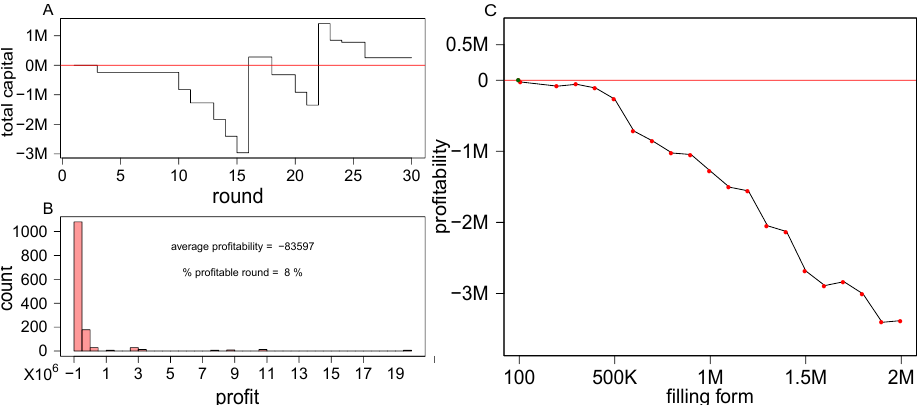
Figure 5. Assessing the selected model’s performance. ( A ) An example of a typical simulation. Vertical jumps of the curve indicate rounds in which the model output was to place a bet in the specific round (x-axis) by filling the 200 K top ranked forms. ( B ) Shows the profit distribution of single rounds from 100 simulations of 30 rounds, in which the model output was to place a 200 K forms bet. The mean profit per round of all simulations as a function of the number of submitted forms is shown in ( C